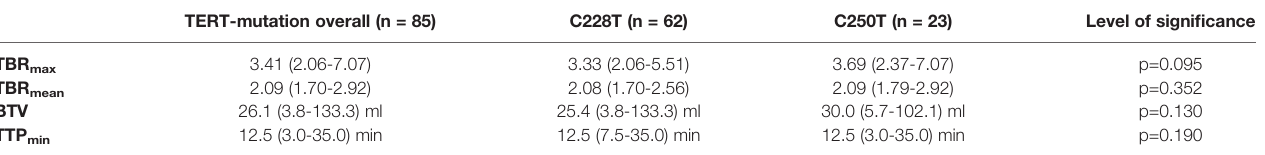
TABLE 3 | In fl uence of TERT-mutation subtypes on 18 F-FET-uptake characteristics [median (range)]. TERT-mutation overall (n = 85) C228T (n =